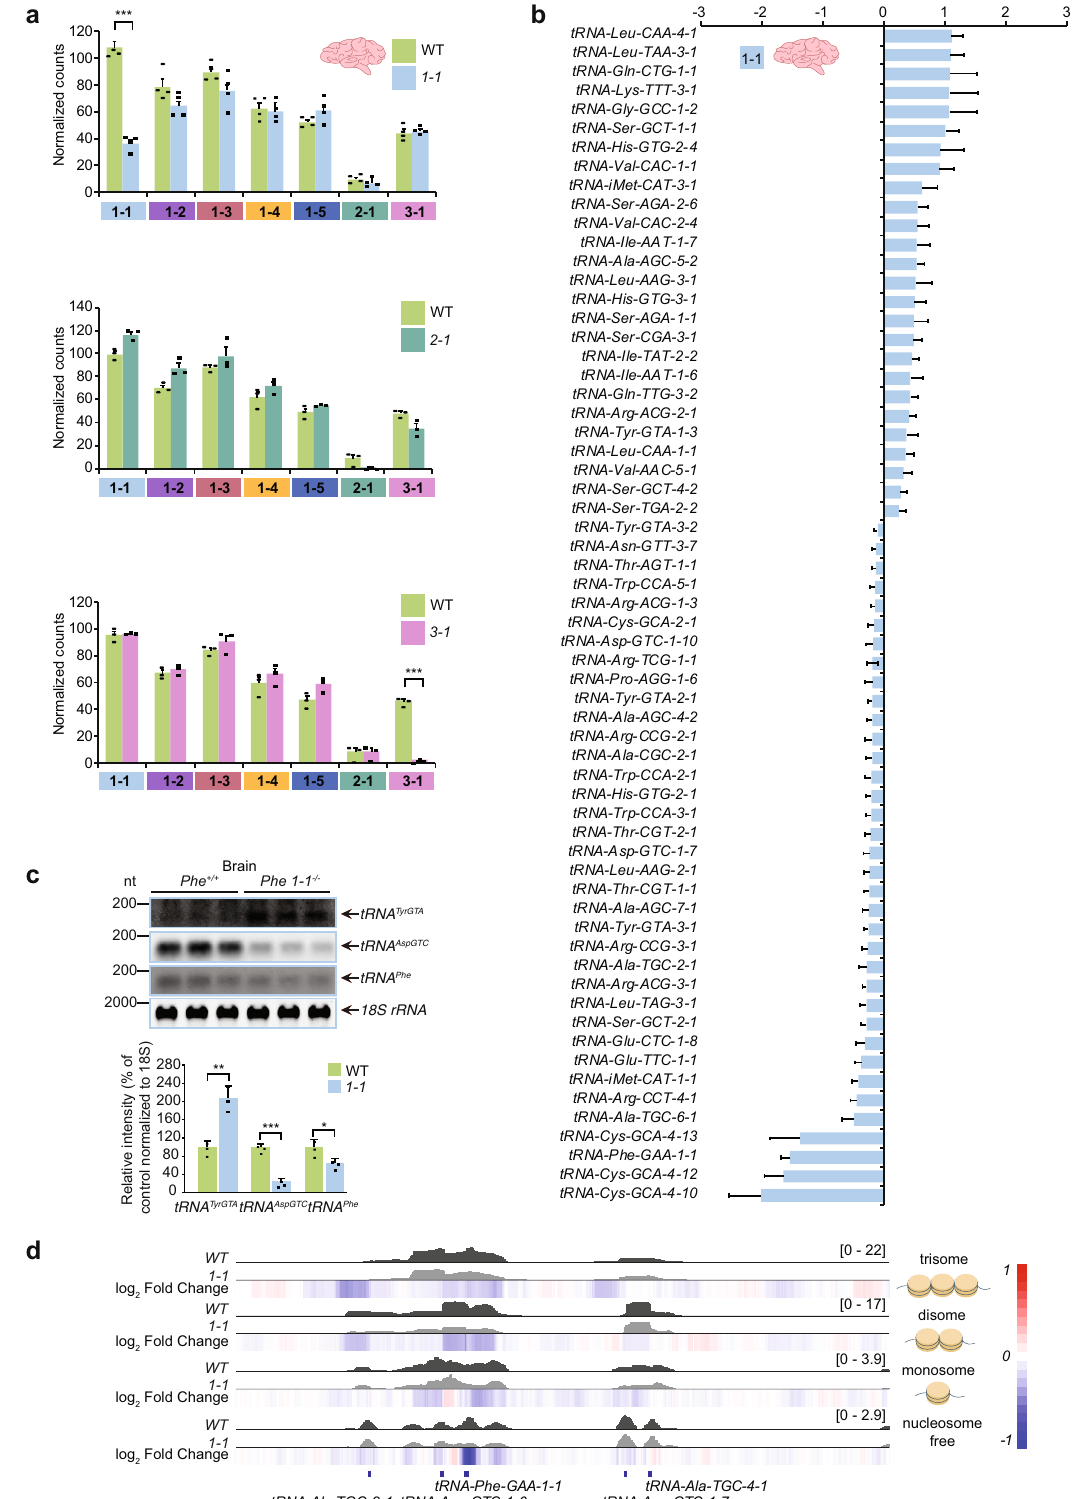
type tRNA-Phe-1-1 geneandfouradditionalhomozygousknockouts(or eight alleles) can result in viable mice that survived without health concernsbeyond10-weeksofage.Thisrevealsthatwhenthe tRNA-Phe- 1-1 geneiseitherpartiallyorfullydeleted,acombinationofuptoseven alleles is compatible with life, however, a greater number of deletions are possible if the tRNA-Phe-1-1 gene is not compromised, indicating